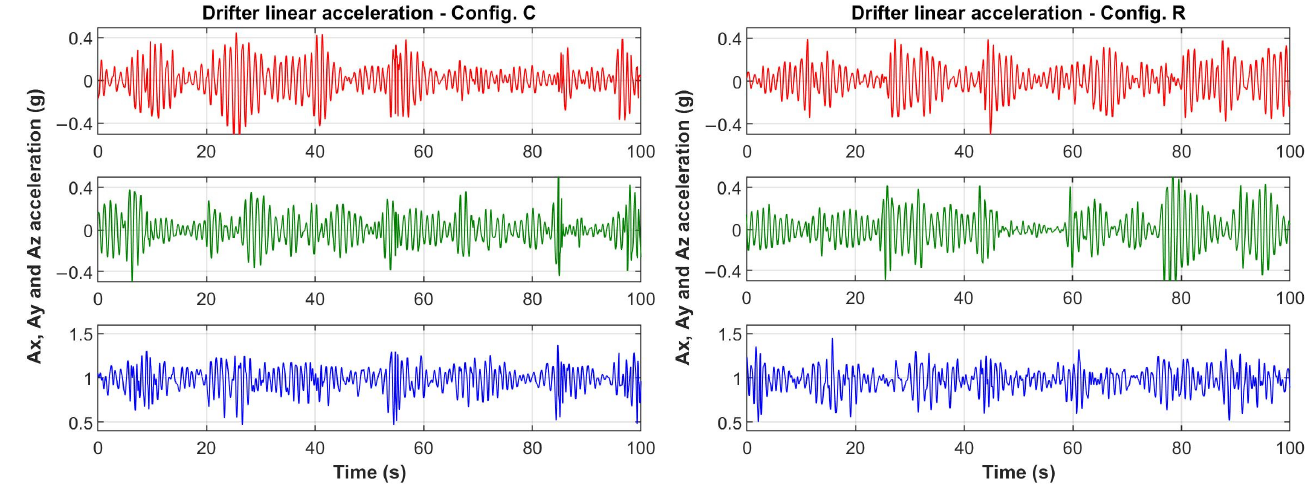
Figure 11. Experimental results for the second test at the sea. ( Left ) config. C. ( Right ) config. R. Both show the time series of the horizontal ( A X : red, and A Y : green) and vertical ( A Z : blue) accelerations of the drifter.